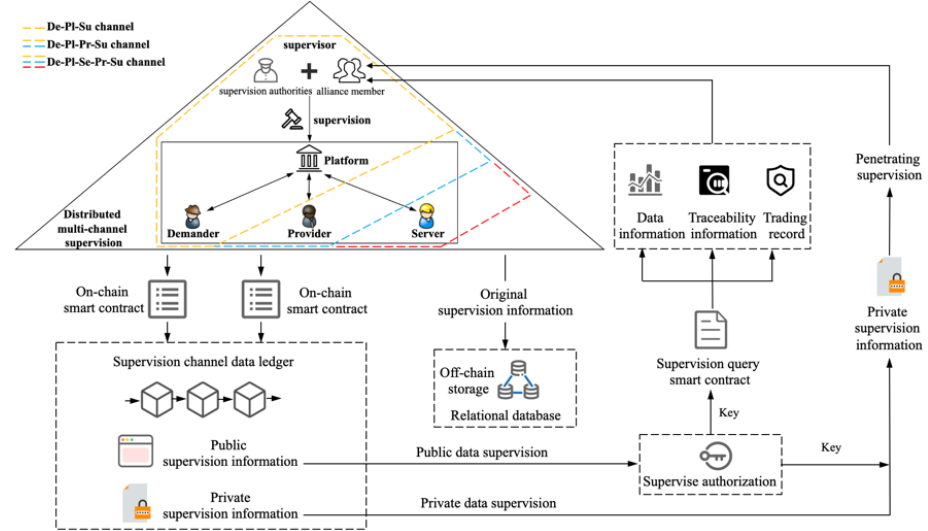
Figure 5. On-chain supervision process of data trading.